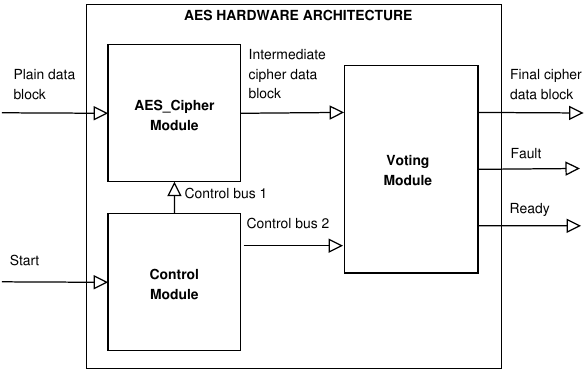
Figure 1. Block diagram of the proposed hardware architecture.